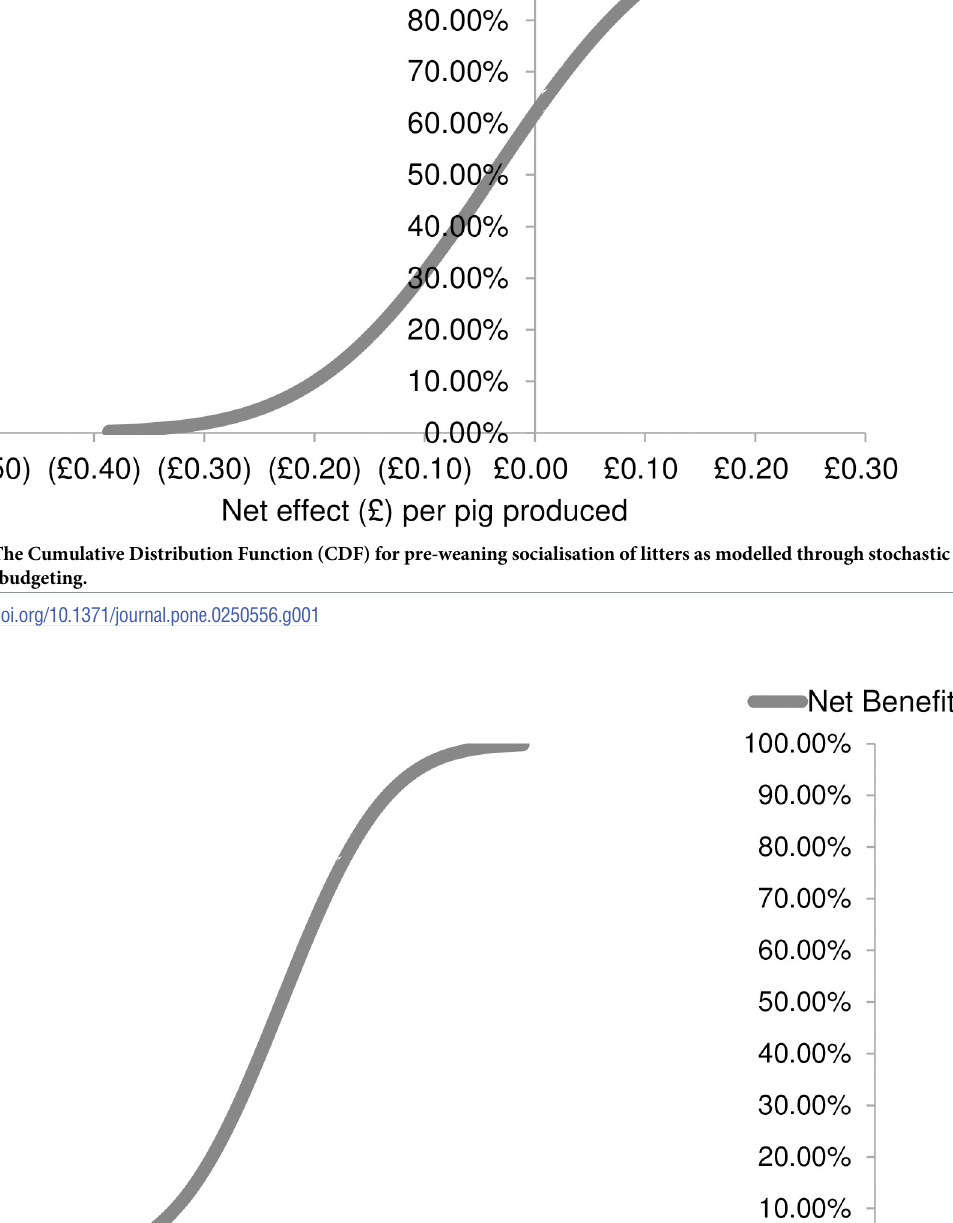
PLOS ONE | https://doi.org/10.1371/journal.pone.0250556 May 5,